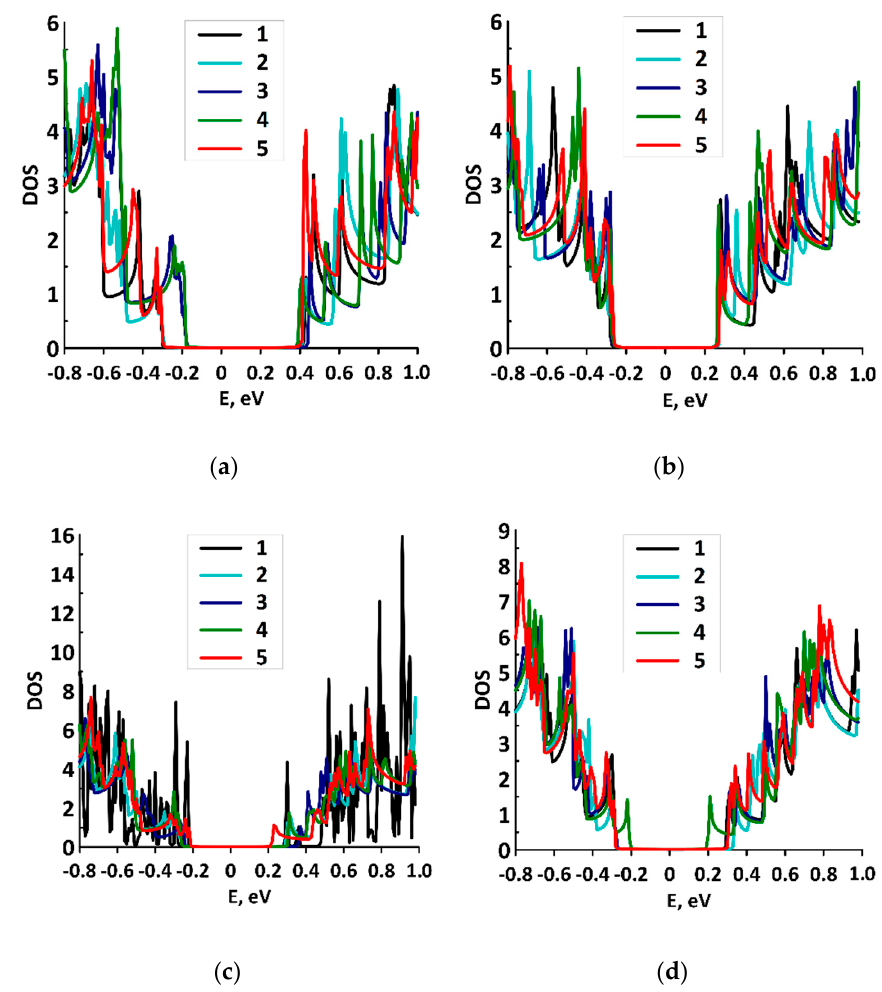
Figure 2. DOS graphs of graphene/SWCNT composite films with different SWCNTs at different distances H1/H2 between SWCNTs: ( a ) film with SWCNT (10,0), numbers 1–5 correspond to the distances H1/H2 6/7–6/11 hexagons; ( b ) film with SWCNTs (12,0), numbers 1–5 correspond to the distances H1/H2 7/8–7/12 hexagons; ( c ) film with SWCNT (14,0), numbers 1–5 correspond to the distances H1/H2 8/9–8/13 hexagons; ( d ) film with SWCNT (16,0), numbers 1–5 correspond to the distances H1/H2 9/10–9/14 hexagons.